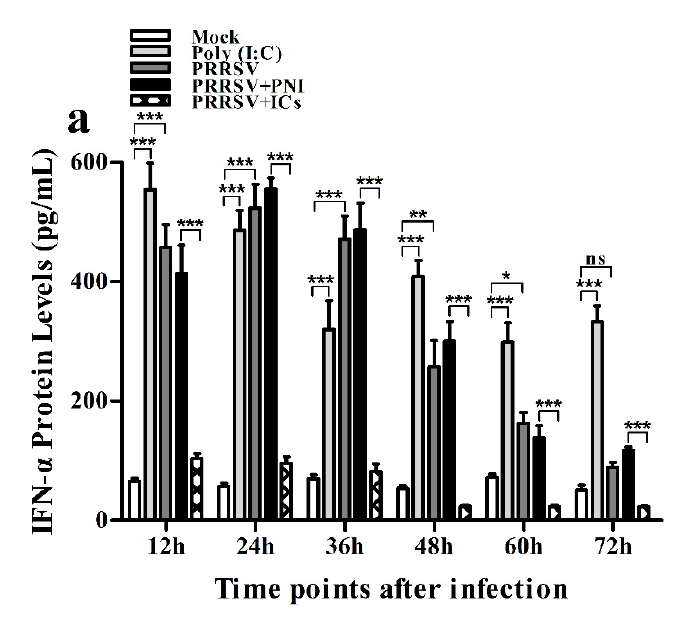
Figure 2. E ff ect of PRRSV infection or PRRSV-ADE infection on mRNA expression of cytokines in porcine AMs. Relative quantitative RT-PCR analysis of cytokine mRNA levels in mock cells, poly (I:C)-stimulated cells, PRRSV-infected cells, PRRSV + PNI-infected cells or PRRSV + ICs-infected cells. ( a ) IFN- α mRNA level, ( b ) TNF- α mRNA level, ( c ) IL-10 mRNA level. *** p < 0.001, * p < 0.05, ns: no significance. Note: PRRSV + PNI: PRRSV + porcine-negative IgG; PRRSV + ICs: PRRSV + porcine IgG against PRRSV; PRRSV-ADE: antibody-dependent enhancement of PRRSV.